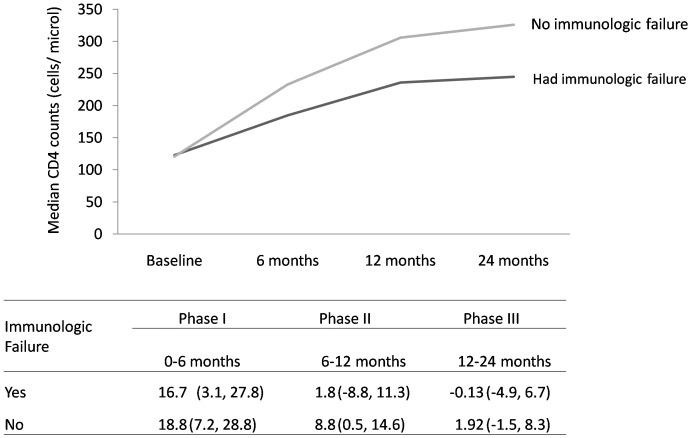
Graph showing the median CD4 count at baseline and at different periods of treatment, stratified by immunologic failure status.The table below the graph indicates the median rate of CD4 increase (cells/µl/month) between the different periods and its IQR.